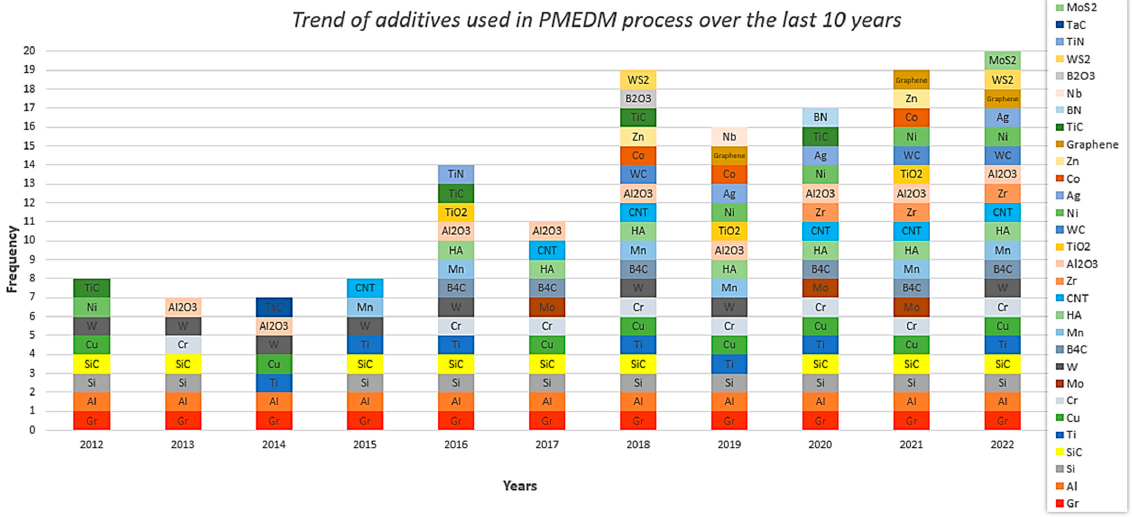
Figure 5. The trend of powder materials utilized for the PMEDM process (Extracted from the databases: Scopus and Web of Science).